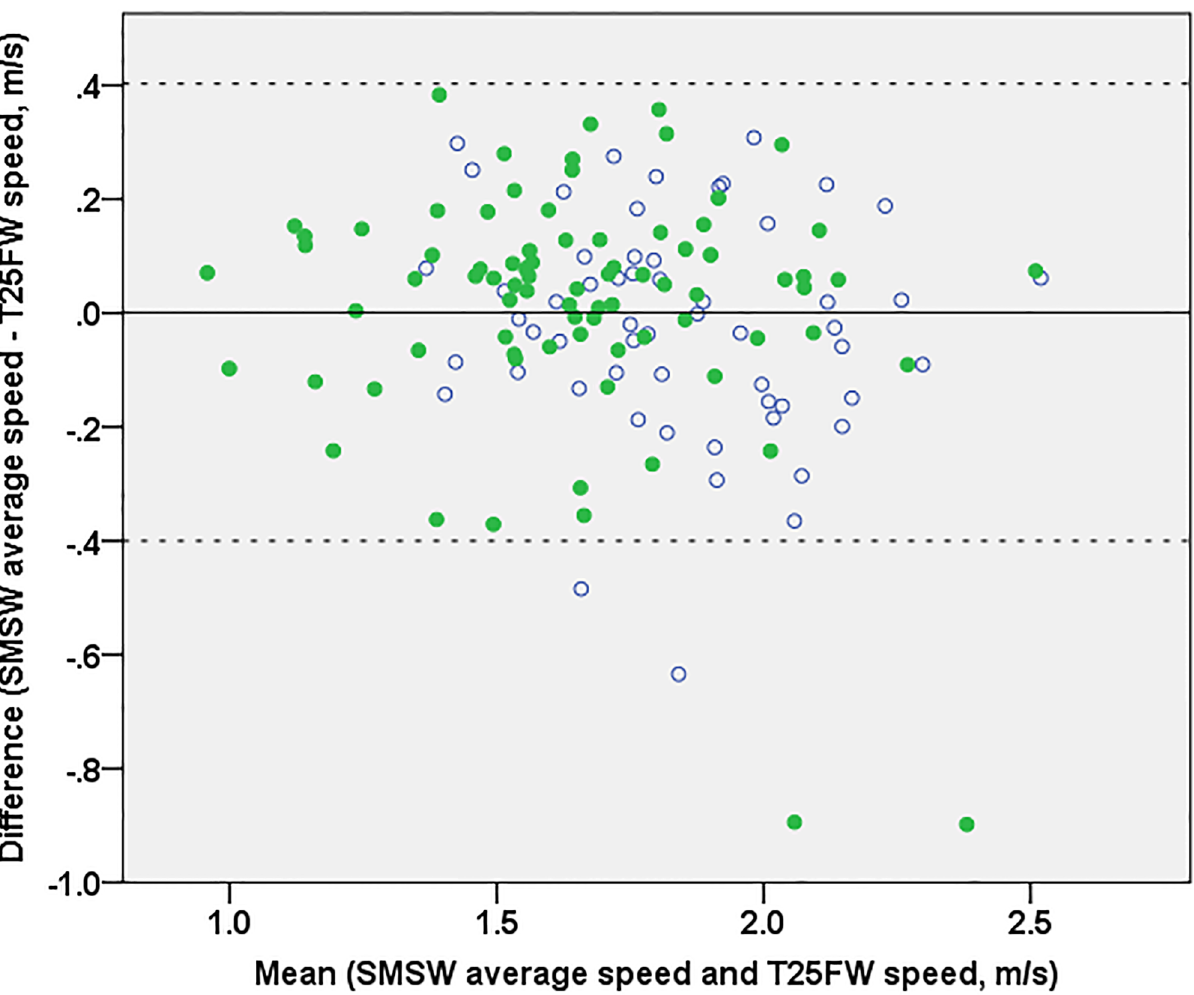
Fig 3. Bland-Altman plot of the differences between SMSW averagespeed and T25FW speed. Mean difference (solid line) and limits of confidence(dashedlines) refer to the whole dataset. For better interpretation, HC are renderedas open circles and PwMS as filled circles. In two HC and two PwMS, the difference betweenboth maximum speeds was outsidethe limits of agreement. All four showedan overestimation of T25FW versus SMSW averagespeedbut did not have any other specific feature in common.